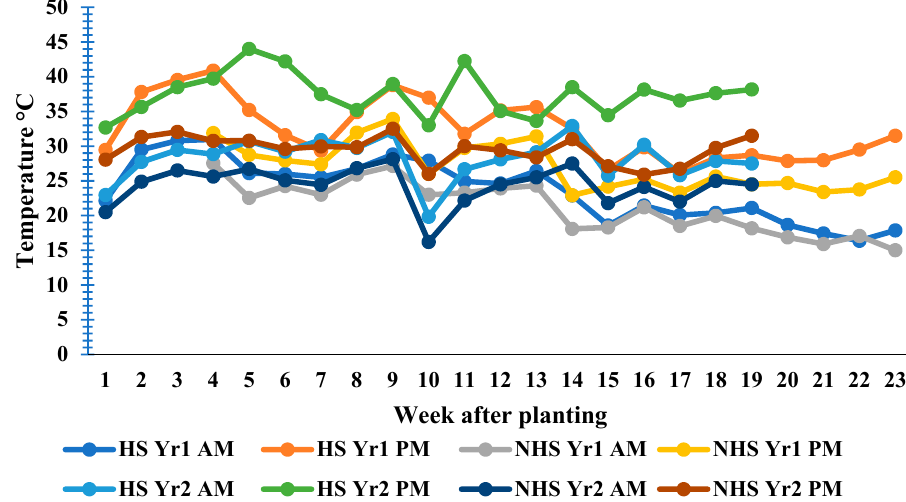
Figure 6. Weekly temperature records for HS and NHS environments for the two seasons plantings (Yr1 = 2018/2019, Yr2 = 2019/2020, AM = morning, and PM = afternoon).